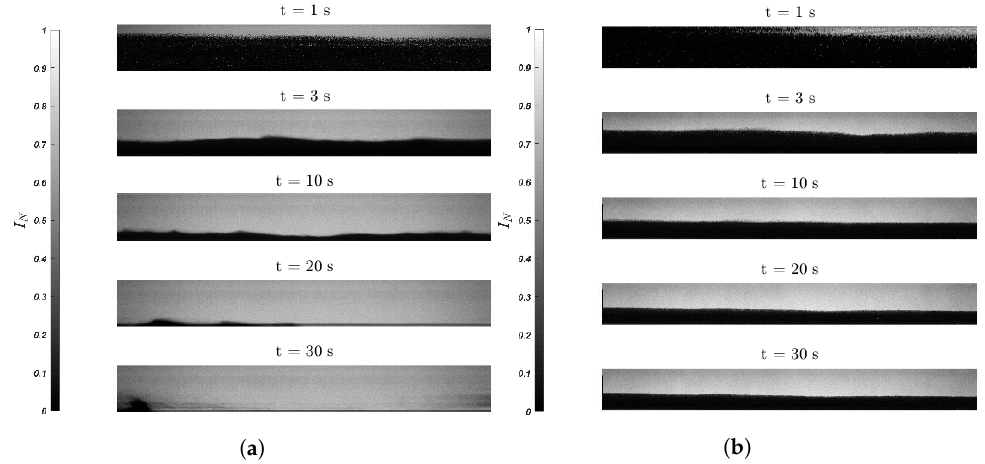
Figure 9. Displacement of Carbopol with ( a ) water in the turbulent regime (Experiment 5) and ( b ) the xanthan solution in the laminar regime (Experiment 6), in a 70% eccentric arrangement.